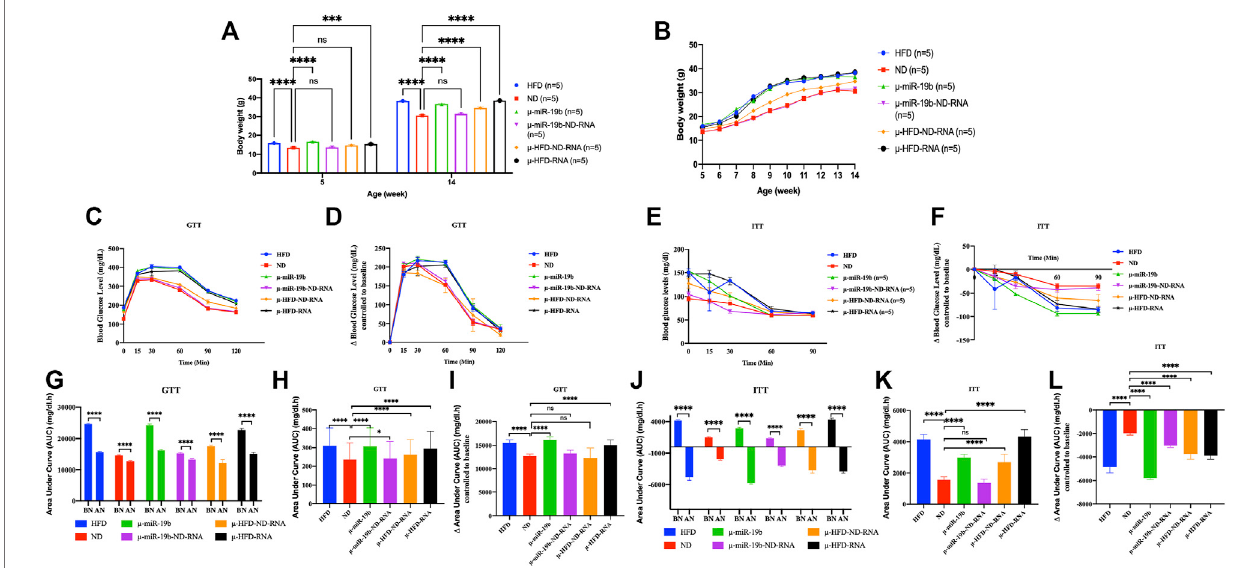
FIGURE3| InductionofobesityanddiabetesinmicebymicroinjectionofmiR-19b-5portotalRNAsofspermintofertilizedmouseeggs.MicroinjectionofmiR-19b- 5p(syntheticRNA)intofertilized mouseeggs(one-cellembryos) leadstoobesityanddiabetesinderivedadultmice.Here,wecompared theactivity ofmiR-19b-5pRNA alone or in combination with total RNA as carrier from spermatozoa from animals raised on ND. All male animals were fed an ND and monitored for body weight, fasting bloodglucose(GTT)andaninsulintolerancetest(ITT)at15 weeks.TotalRNAfromspermatozoafrommalesraisedonanormaldiet(ND)suppressestheactivityof miR 19b-5p in the induction of obesity and type 2 diabetic (T2D) phenotype. We also compared the activity of the total RNA of sperm from animals fed with HFD alone (1 g/ml) or in combination with total RNA from sperm (1 g/ml) as carrier from animals raised in ND. Total sperm RNAs from ND animal do not completely suppress the inductionofHFD-MediatedPhenotypes(HFD-MPs)oftotalRNAfromspermfromHFDanimalsbutareductionisobservedintheexpressionofHFD-MPs.n=numberof mice in each group. (A) Body weight of males born after microinjection of miR-19b-5p in each group at the age of 5 weeks to 14 weeks. Statistical analysis was performedbytwo-tailed,one-wayanalysisofvariance(ANOVA),uncorrectedFisher ’ sleastsigni fi cantdifference(LSD).****p < 0.0001(NDvs.eachgroup); ***p < 0.001, ****p < 0.0001. (B) Body weight of males in each group from 6 – 14 weeks of age. (C) Blood glucose during the glucose tolerance test (GTT). Statistical analysis was performed bytwo-tailed, two-way ANOVA, uncorrectedFisher ’ sLSD.****p < 0.0001(ND vs. HFD); #### p < 0.0001(ND vs. µ-miR-19b); +++ p < − 0.001(ND vs. µ-HFD- ND-RNA), xxxx p < 0.0001(ND vs. µ-HFD-RNA). The area under curve (AUC) (Virtue and Vidal-Puig, 2021) were also calculated after normalization based on the glucose levels of each time point (D,F) . (E) Relative blood glucose during the insulin tolerance test (ITT). Statistical analysis was performed by two-tailed, two-way